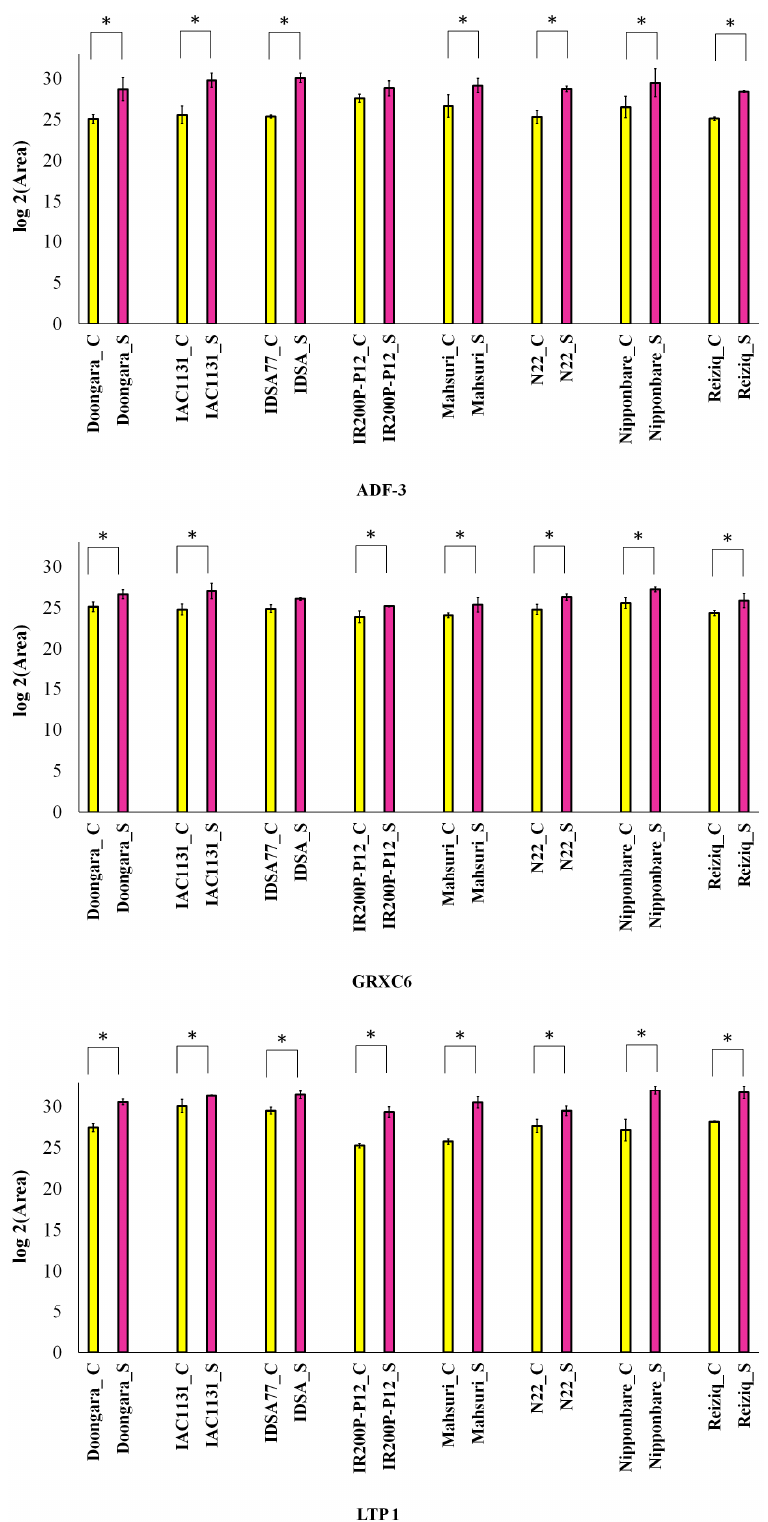
Figure 5. PRM verification of three proteins induced in all genotypes of rice. The bars illustrate the measured relative abundance of ADF-3, GRXC6, and LTP 1 in all eight rice genotypes under control (C) and drought stress (S) conditions, with statistically significant differences according to the Mann–Whitney U-test indicated ( p -values < 0.05) by an asterisk (*). Error bars show the standard deviation calculated from three replicate experiments.